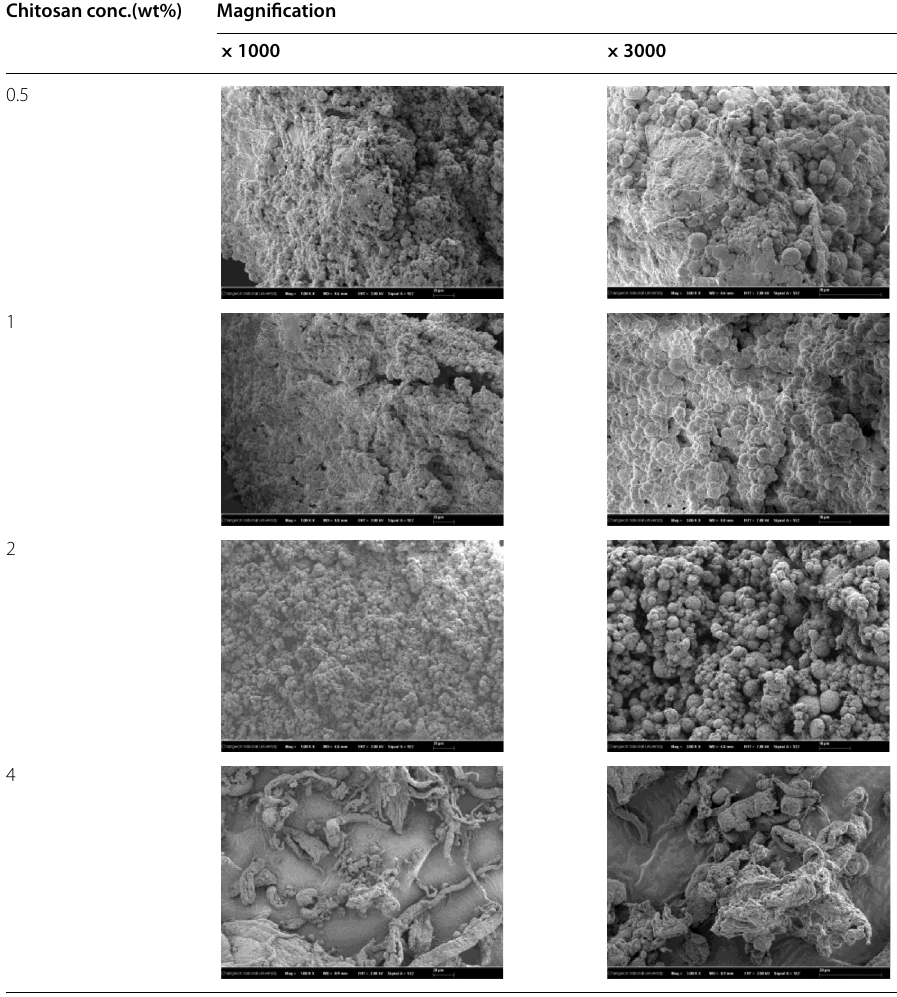
Table 2 Microscope images of synthesized microcapsules according to chitosan